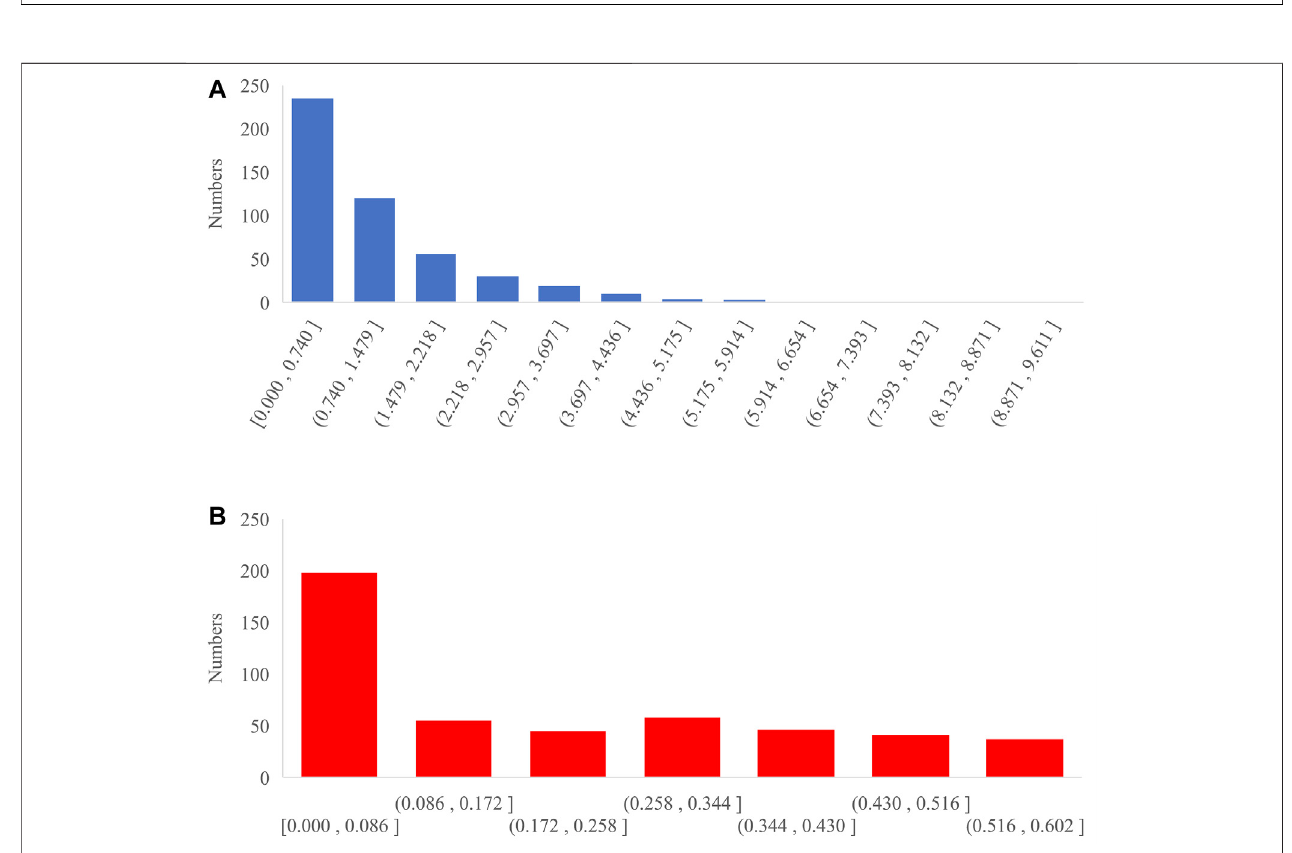
FIGURE 11 | Absolute error distributions of the persistence model and ours. (A) Persistence model. (B) Ours.